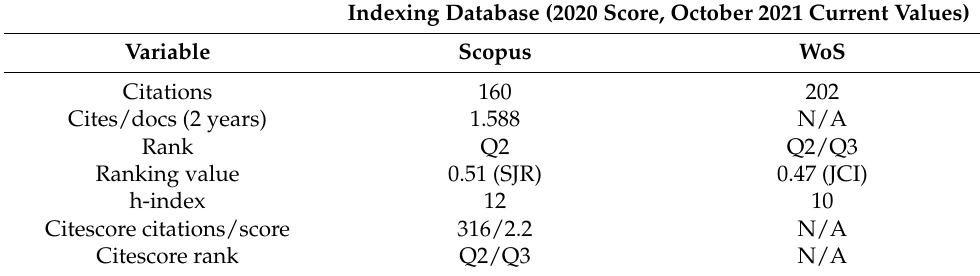
Table 2. Comparison of scoring values of the analysed journal in Scopus and WoS.